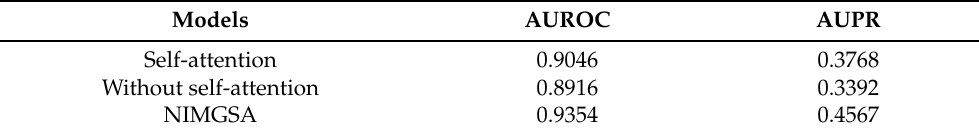
Table 6. Ablation studies.